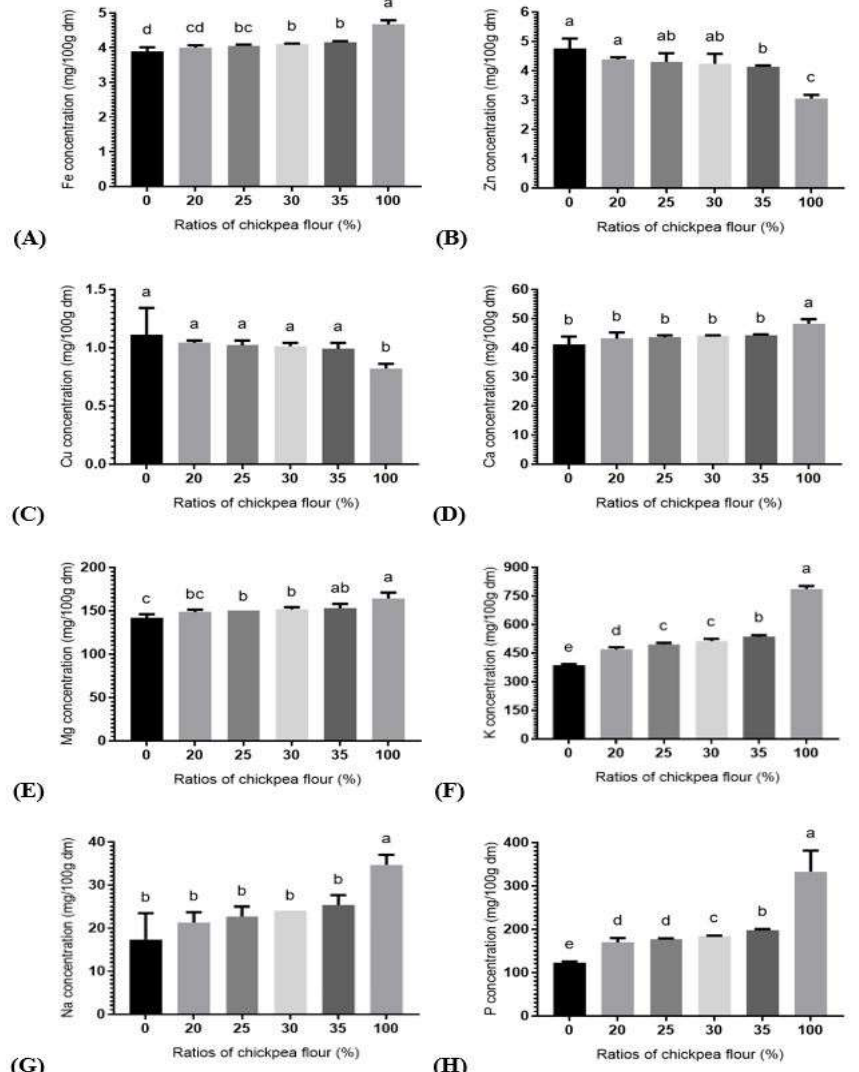
Figure 1. Mineral composition of durum wheat flour, fortified durum wheat flour and chickpea flour; ( A – H ) represent Fe, Zn, Cu, Ca, Mg, K, Na, and P concentrations, respectively. Values are mean ± SD ( n = 3). Means with different superscript letters within the same graph indicate significant statistical differences, p -value ≤ 0.05.